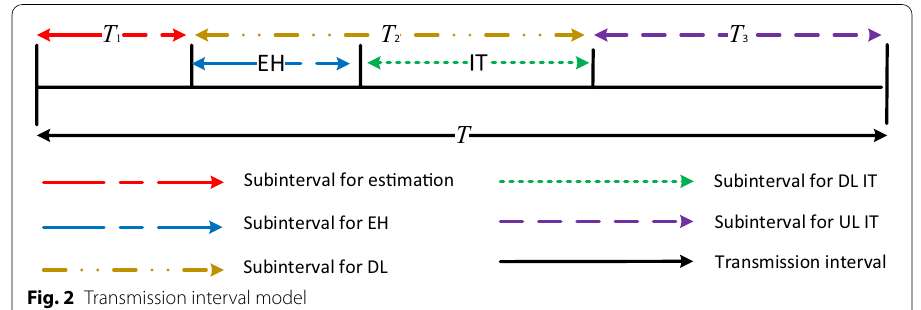
Fig. 2 Transmission interval